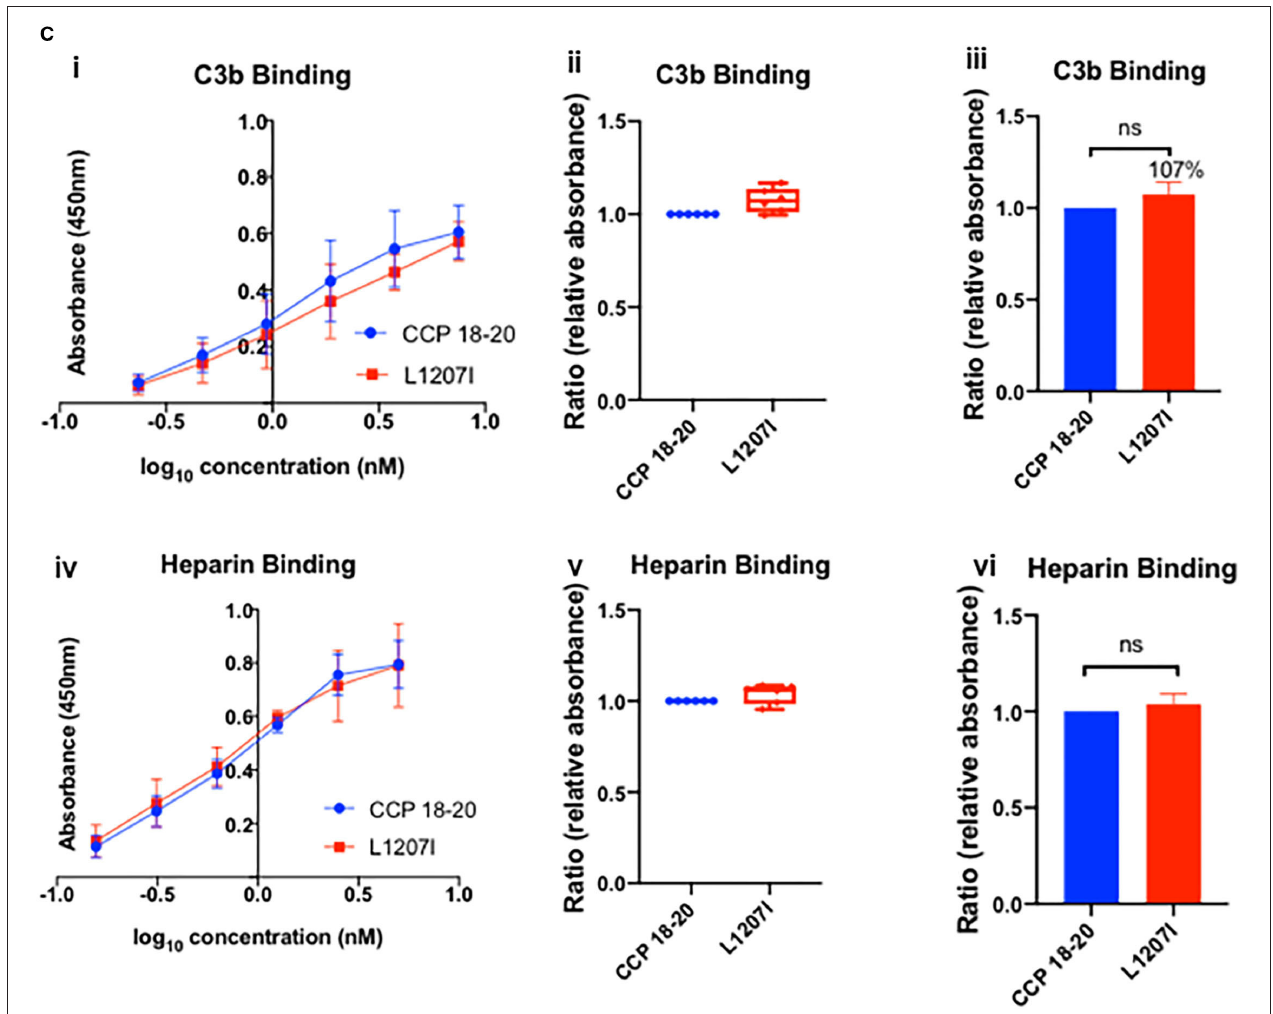
FIGURE 6 | Structural analysis of L1207I. (A) Structure of the CCP 19–20:C3d complex containing one molecule of CCP 19–20 and two molecules of C3d (PDB ID 2XQW, green and purple) (40). Residues located at the CCP 20 interface are annotated and shown as cyan sticks. Residues located at the C3d interface are shown as magenta sticks. Close-up view of the CCP 20-C3d interface is shown and reoriented in the inset box. R1182, W1183, and T1184 mutations shown as cyan sticks were reported in aHUS cases ( 40). Functional study of W1183L demonstrated impaired interaction with surface-bound C3b (14). E160 and R1203, D163 and K1230, D292 and R1231 form salt bridges with distances of approximately 2.5, 2.5, and 3.3 Å, respectively. L1207 (in cyan) is located away from the C3d-CCP 20 interaction surface. (B) Sialic acid binding site on complement CCP 20 (PDB ID 4ONT) (41)—C3d (magenta); CCP 19 (orange); CCP 20 (green); α -N-acetylneuraminic acid (Neu5AC, orange stick). L1207 (cyan) is spatially distant from the binding surface between Neu5AC and CCP 20. R1210 mutations (green sticks) have been reported in aHUS. (42). Functional analysis of L1207I (C) (i, iv) Absorbance is plotted against logarithmic protein concentrations. (ii, v) Box-and-whisker plots demonstrating C3b and heparin binding (by ELISA) of L1207I compared to WT. (iii, vi) Representation of C3b and heparin binding of L1207I compared to WT using bar graphs. There is no difference in C3b or heparin binding for L1207I compared to WT. Data represent three separate experiments, bars correspond to